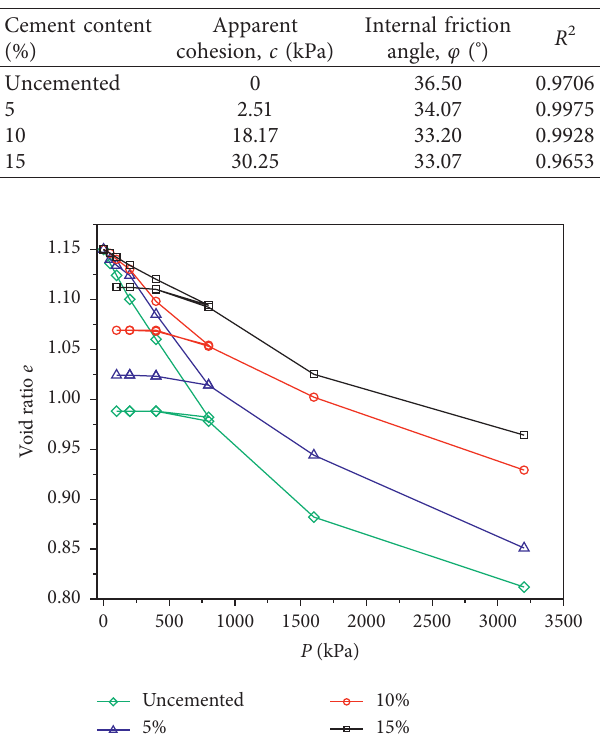
Figure 7: Oedometer curves of calcareous sand with and without